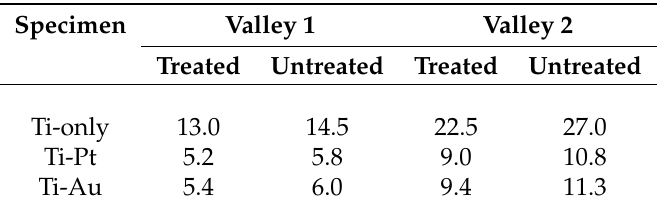
Table 3. Valley frequencies observed in Ti-only specimens and expected valley frequencies in Ti-Pt and Ti-Au specimens based on the mass ratio defined in Table 2 (unit: